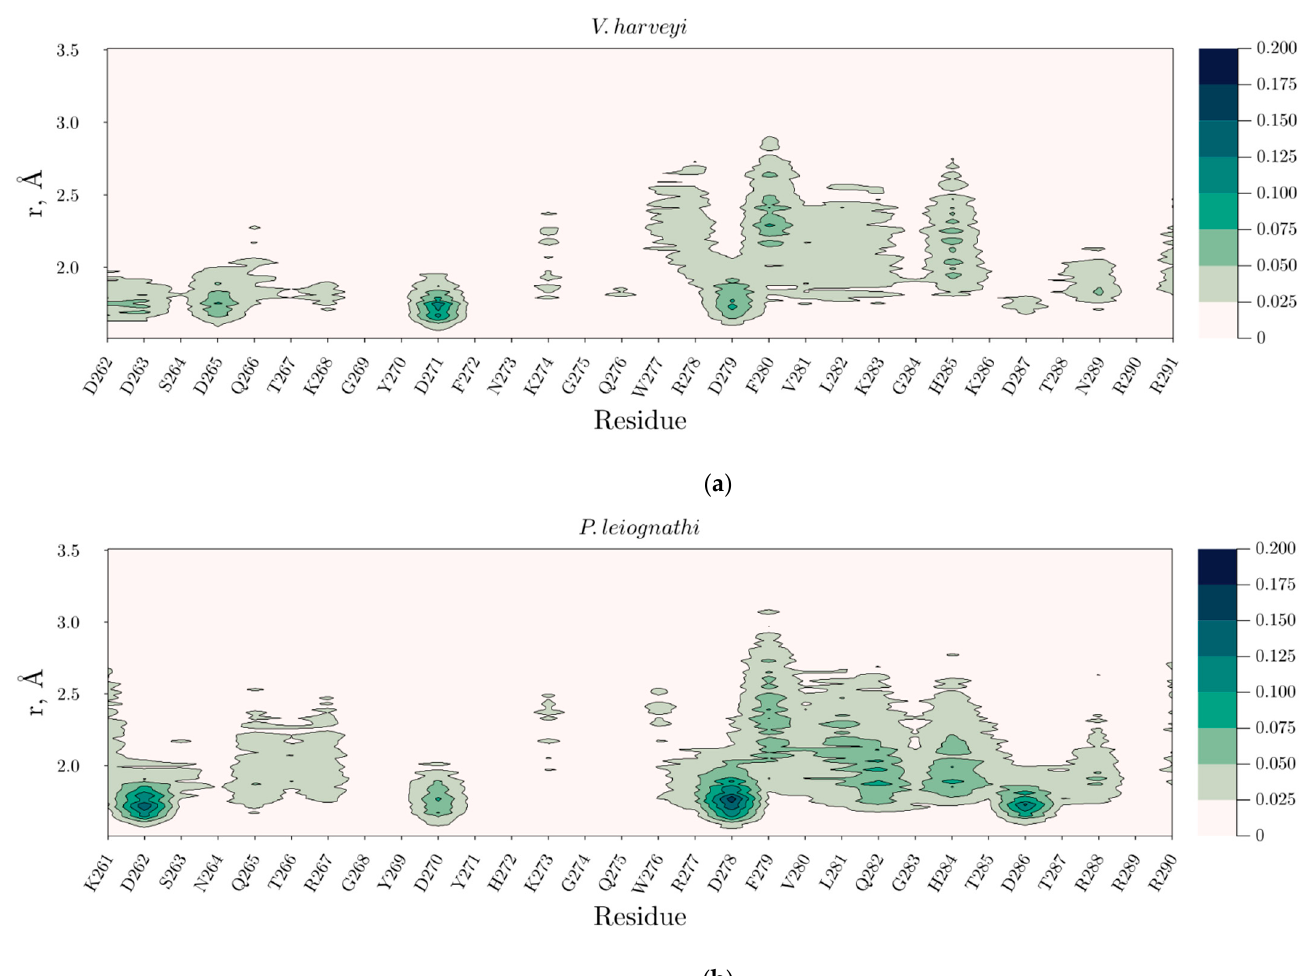
( d ) Figure 6. Δ RMSF of C α atoms of V. harveyi luciferase mobile loop (262–291 a. r.) in water ( a ) and water-sucrose ( c ) and P. leiognathi luciferase mobile loop (261–290 a. r.) in water ( b ) and wa- ter-sucrose ( d ) at different temperatures. The positive value of Δ RMSF corresponds to a more flexible segment as compared with the structure in water at 27 ° С , while the negative Δ RMSF cor-